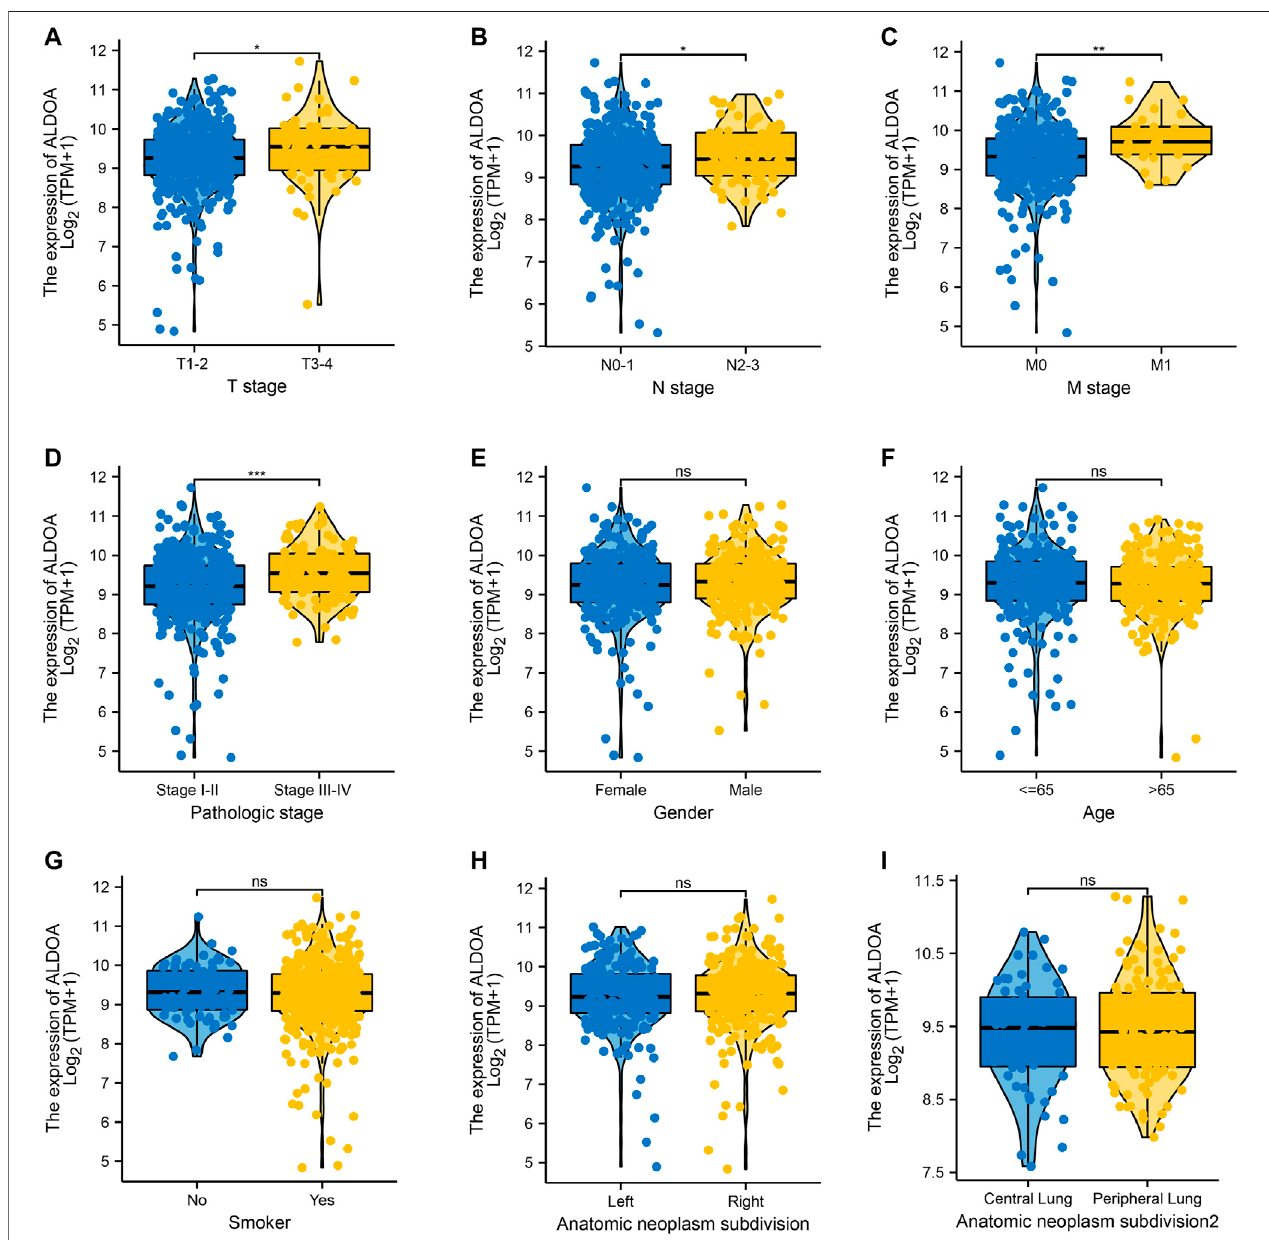
FIGURE3| TherelationshipbetweenclinicopathologicalcharacteristicsandALDOAexpressioninlungadenocarcinomapatientsfromTCGA (A-D) ALDOA mRNA expression was signi fi cantly increased with high T stage, N stage, M stage, and TNM stage (E-I) No signi fi cant differences were found in gender, age, smoke condition, and anatomic subdivision (right vs left, central vs peripheral) (ns, no signi fi cant; *, p < 0.05; **, p < 0.01, ***, p < 0.001).